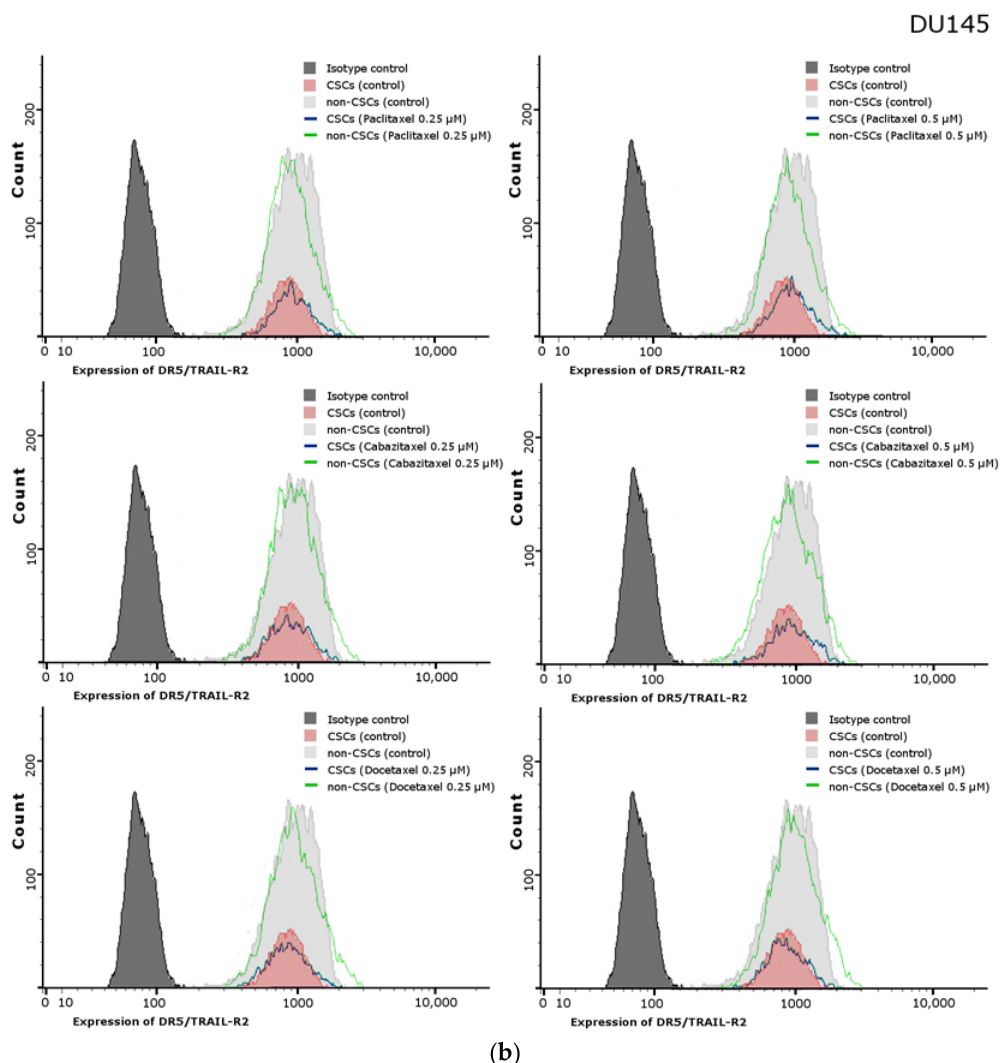
Figure 8. Effects of paclitaxel, cabazitaxel or docetaxel on expression of TRAIL-R2 on the surface of CSCs and non-CSCs subpopulations within: PC3 ( a ); and DU145 ( b ) prostate cancer cells. The dark grey histogram shows isotype control, red corresponds to CSCs, light grey histogram shows non-CSCs, blue line shows CSCs after treatment with adequate taxane, and green line corresponds non-CSCs treated with adequate taxane.